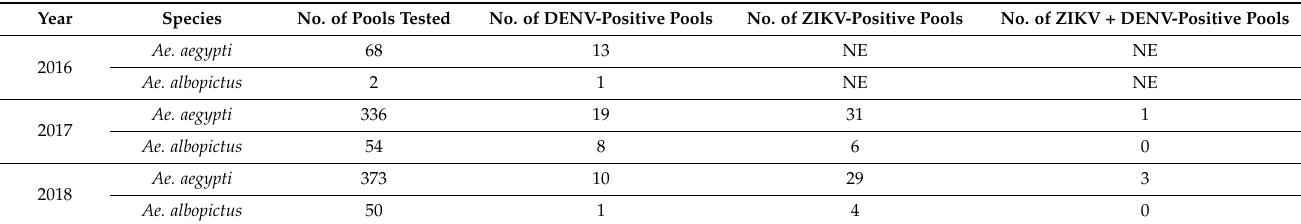
Table 4. Detection of dengue and Zika viruses in Ae. aegypti and Ae. albopictus collected in schools of Medell í n, Colombia, between 2016 and 2018. NE: Non-evaluated.